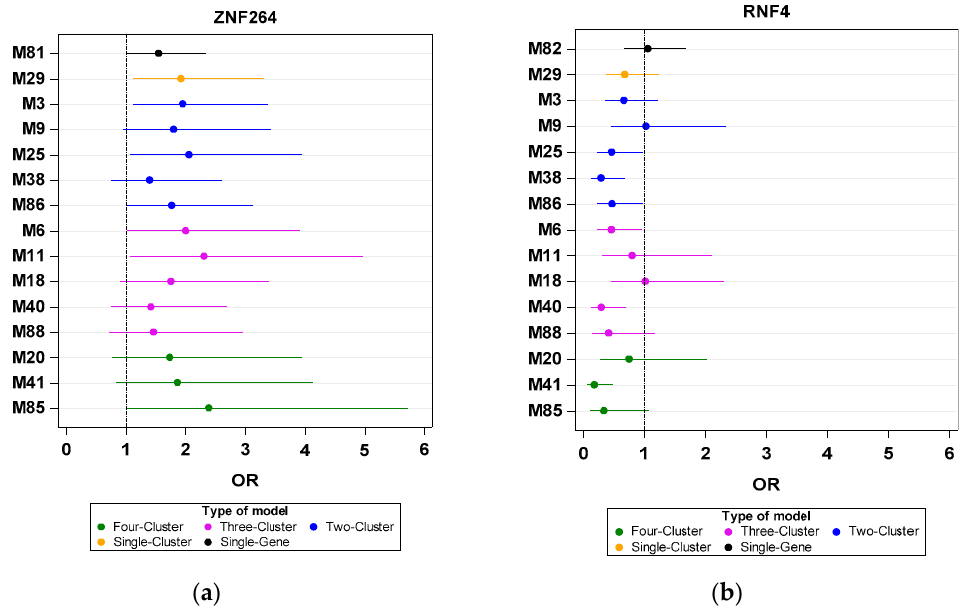
Figure 5. Odds ratios (ORs) of investigated genes based on single-gene, single-cluster, and multiple- cluster analyses. The X- and Y-axes are the OR and Model ID, respectively. ( a ) ZNF264 and ( b ) RNF4.